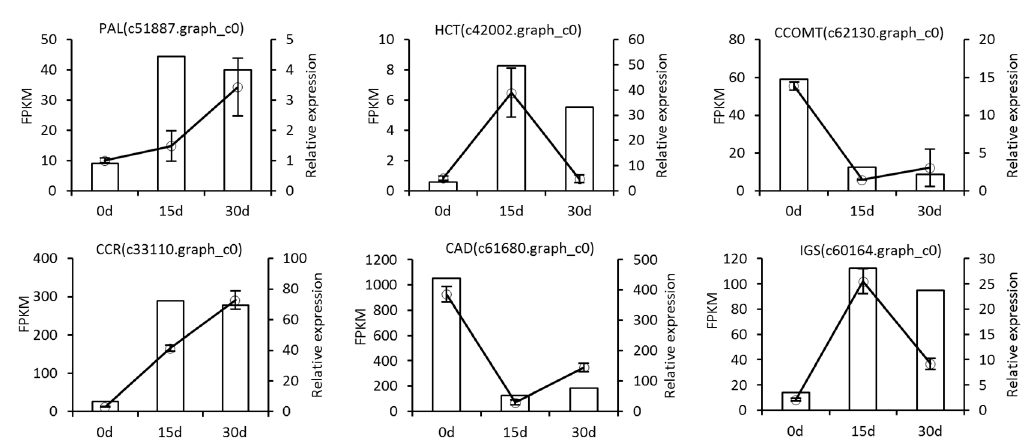
Figure 7. qRT-PCR validation of the expression of six DEGs involved in methyleugenol biosynthesis pathway. The x-axis shows the three samples, the y-axis shows the relative quantitative expression level and FPKM value of each unigene.